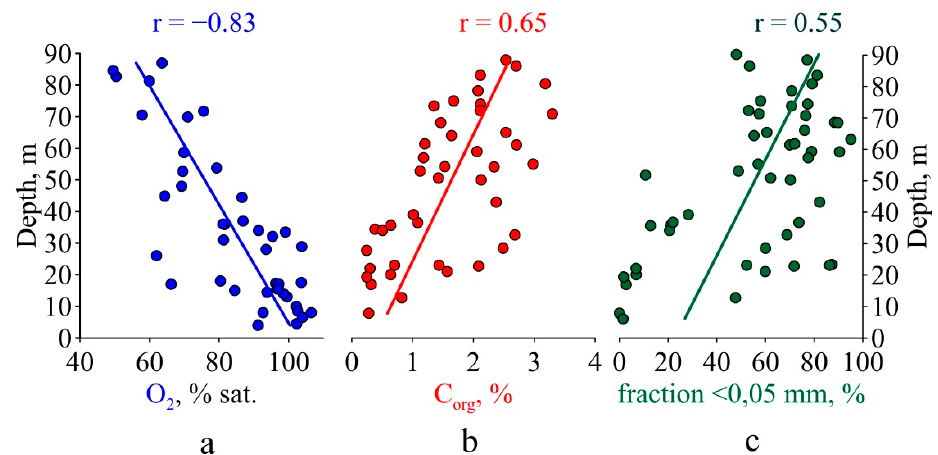
Figure 9. Dependence of the value distribution on depth: ( a ) the oxygen saturation of the bottom waters; ( b ) the content of C org in the surface layer of the sediment; ( c ) the proportion of the pelite-aleuritic fraction in the surface layer of the sediment.